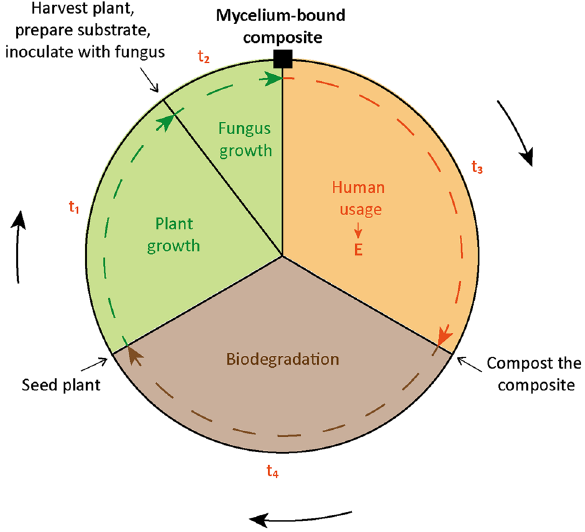
Figure 1. Life cycle of MBCs. E represents the elastic modulus and t i is the time for the phase i of the cycle: 1, growth of the plant that will make the ligno-cellulosic substrate, 2, growth of the mycelium, 3, usage, and 4, biodegradation in